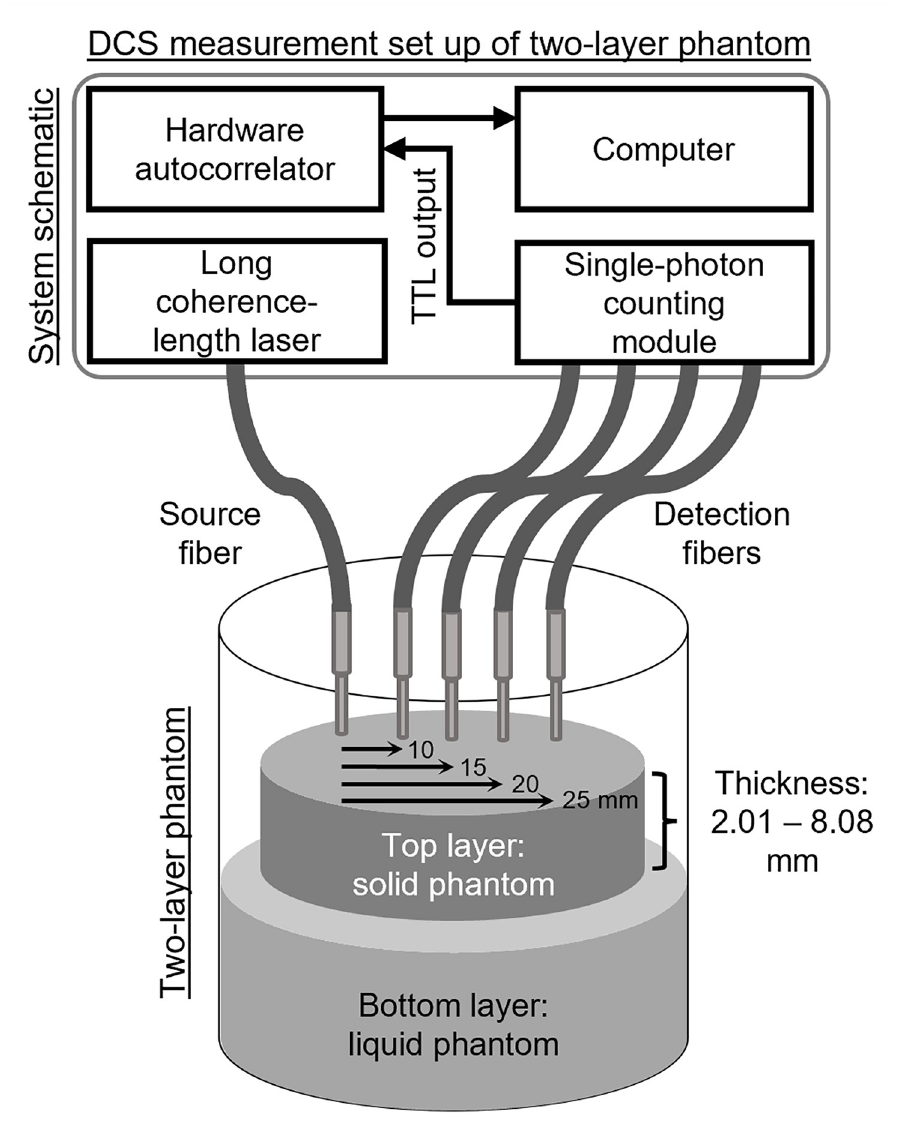
Fig 2. Schematic of the custom DCS system and setup for the two-layer phantom experiment with a single source fiber and four detection fibers at 10 mm, 15 mm, 20 mm and 25 mm from the source fiber. The top and bottom layers are solid and liquid phantom layers